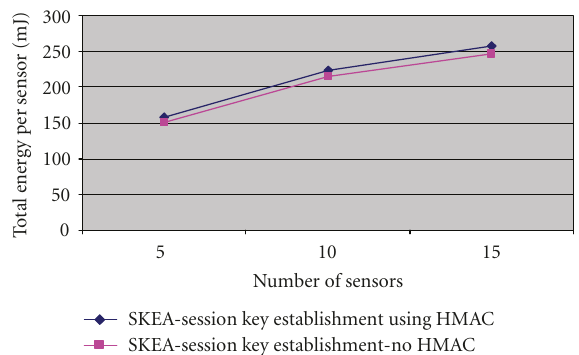
Figure 10: Total energy required per sensor to establish session key using SKEA (with and without HMAC authentication).